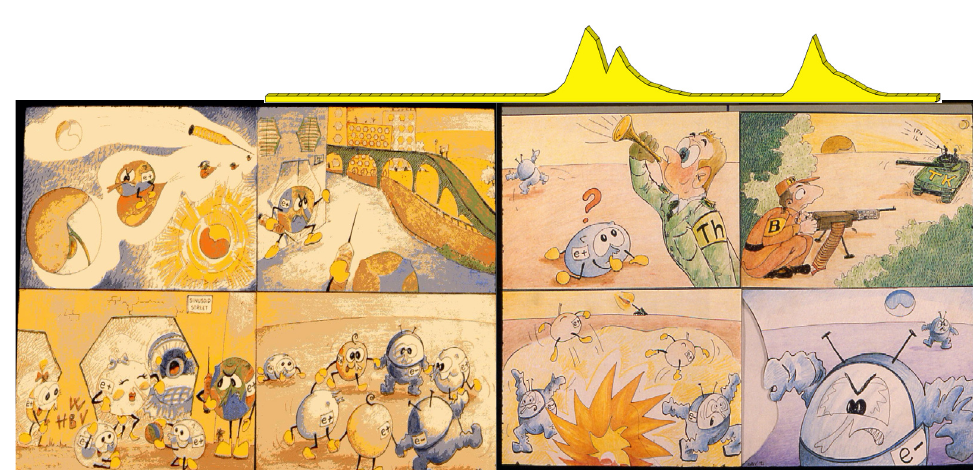
Figure 1. At the meeting on the Pathogenetic Implications of HBV Heterogeneity of 5–7 April 1991 in Sestriere, Italy, our group proposed, in a cartoon, depicted as poster, a hypothetical theory to explain the clinic–pathologic implications of the differential expression of HBeAg provided by wild-type HBeAg-positive virus and HBeAg-defective variant. The 4 pictures on the left side of the cartoon outline the induction of persistent HBV infection without liver injury favored by wild-type HBV population. The 4 pictures on the right side represent, in sequence from top to bottom, the induction of anti-HBV inflammatory response that leads to the selection of HBeAg-negative variants behaving as immune escape mutants.